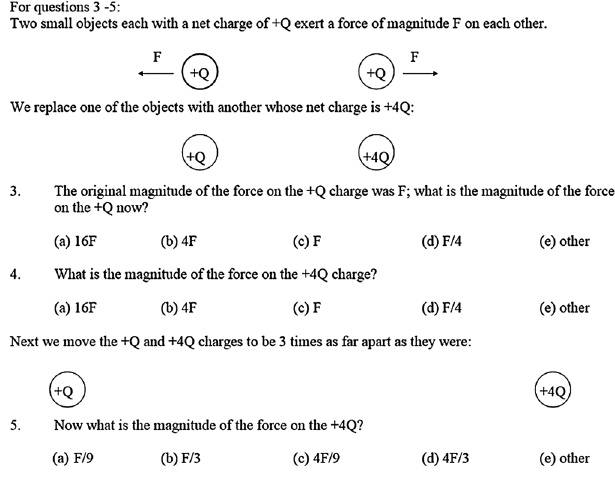
FIG. 1. Questions 3, 4, and 5 on the